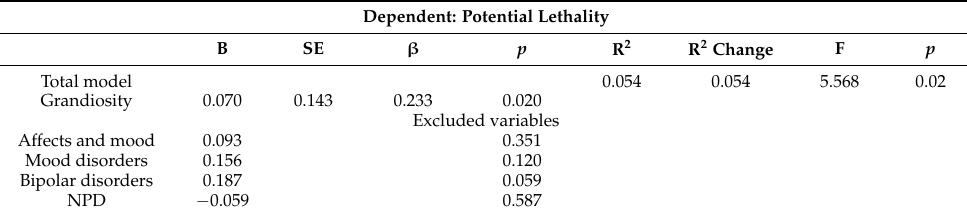
Table 3. Regression analysis.